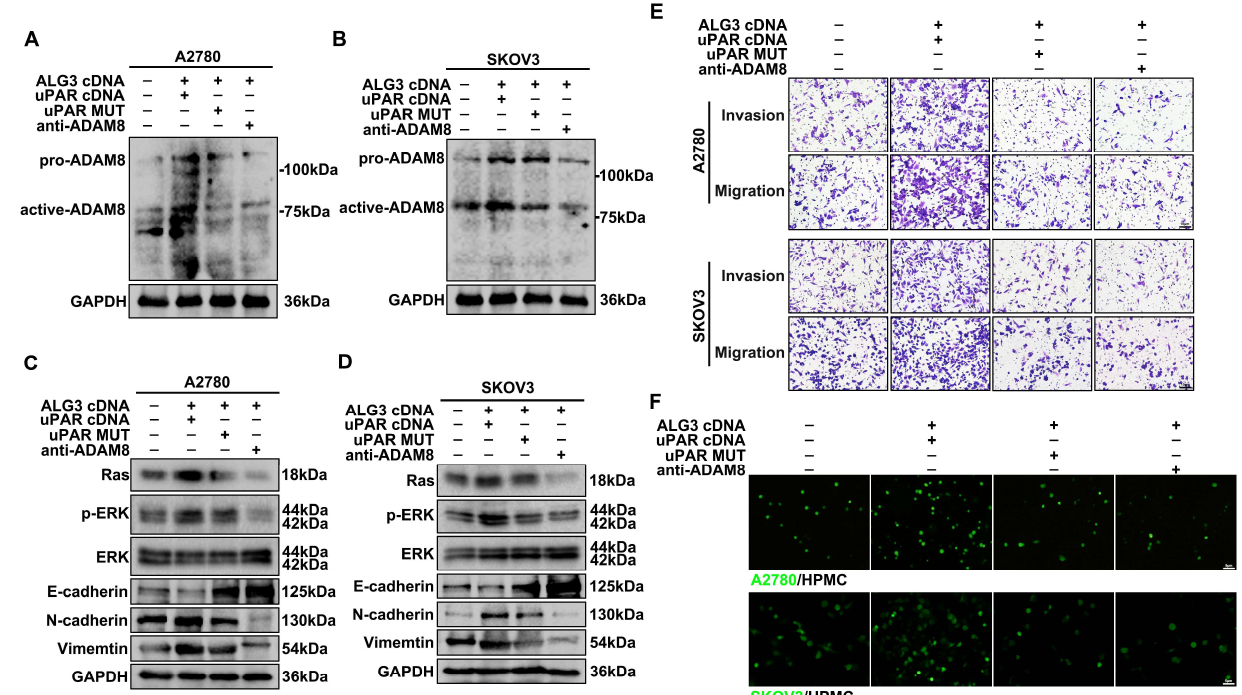
Figure 6. α 1,3-mannosylated uPAR binding with ADAM8 stimulates ovarian metastasis by activating the Ras/ERK signaling pathway. ( A , B ) Western blot analysis of ADAM8 expression after ALG3 cDNA with uPAR cDNA or uPAR MUT cDNA co-transfection and antibody blockade of ADAM8 in A2780 ( A ) and SKOV3 ( B ) cells. ( C , D ) Western blot analysis of Ras, p-ERK and ERK expression, as well as EMT markers (E-cadherin, N-cadherin and Vimentin) expression. ( E ) The migration and invasion potential detected by transwell migration/Matrigel invasion assay. ( F ) Representative images of fluorescently labeled A2780 and SKOV3 cells adhering to HPMCs. Bars represent 5 μm ( F ) and 10 μm ( E ).